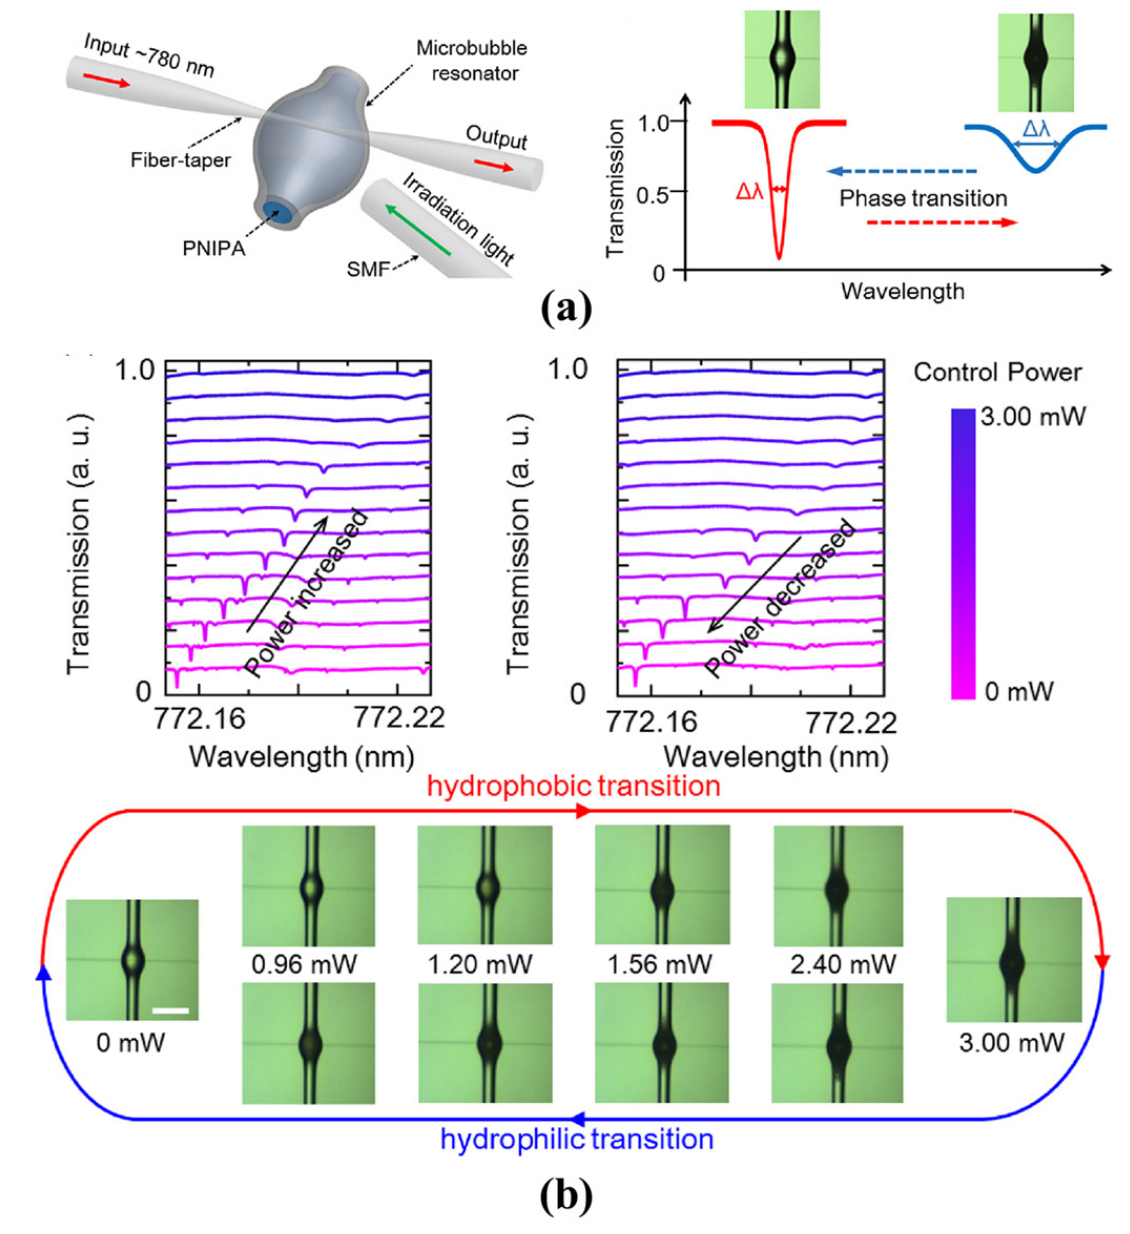
Figure 13. Sensing of the hydrogel phase transition between hydrophobic and hydrophilic (reprinted with permission from [92], © The Chinese Laser Press): ( a ) schematic of the hydrogel sensing system with a microbubble resonator; ( b ) resonance wavelength shift, spectral linewidth broadening, and scattering enhancement from hydrophilic to hydrophobic.